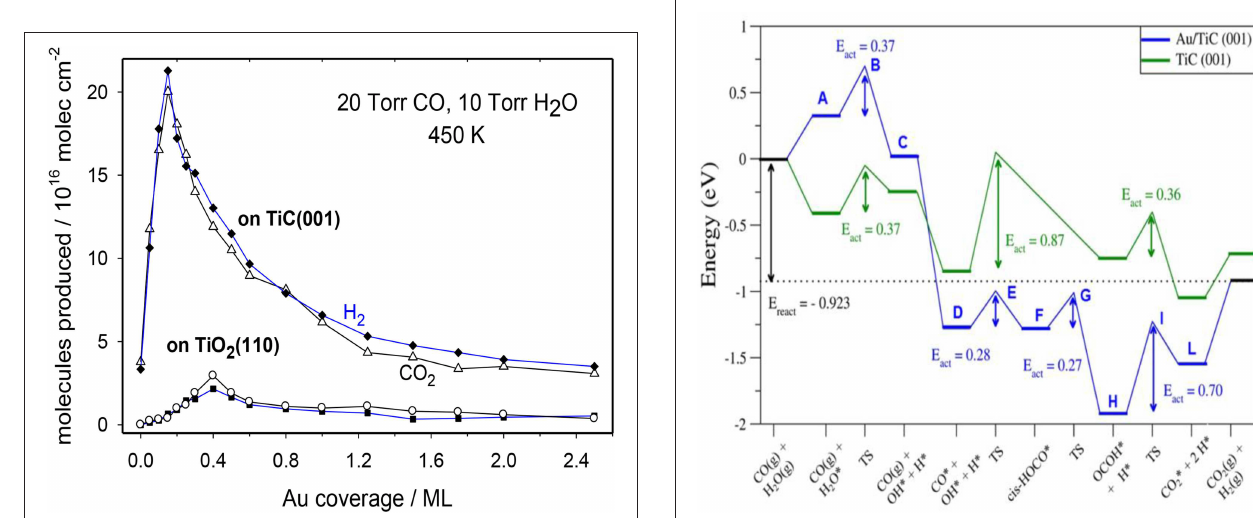
FIGURE 4 | Catalytic activity for the LT-WGS on Au/TiC(001) and Au/TiO 2 (110) surfaces as a function of Au coverage. T = 450K, 10 Torr of H 2 O and 20 Torr of CO. Reproduced with permission from Rodriguez et al. (2014), copyright 2014 by Wiley.